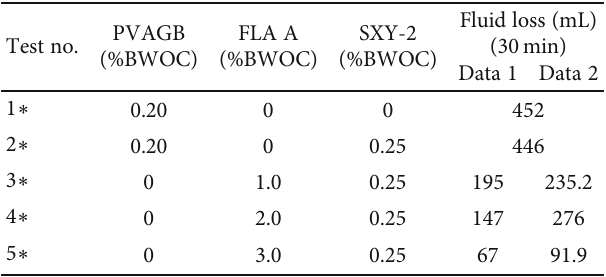
Table 3: Fluid loss test 1.